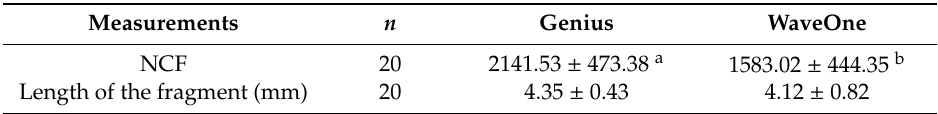
Table 3. Means ± standard deviations of the numbers of cycles to fracture (NCF) and lengths of fractured fragments between instrument systems tested.